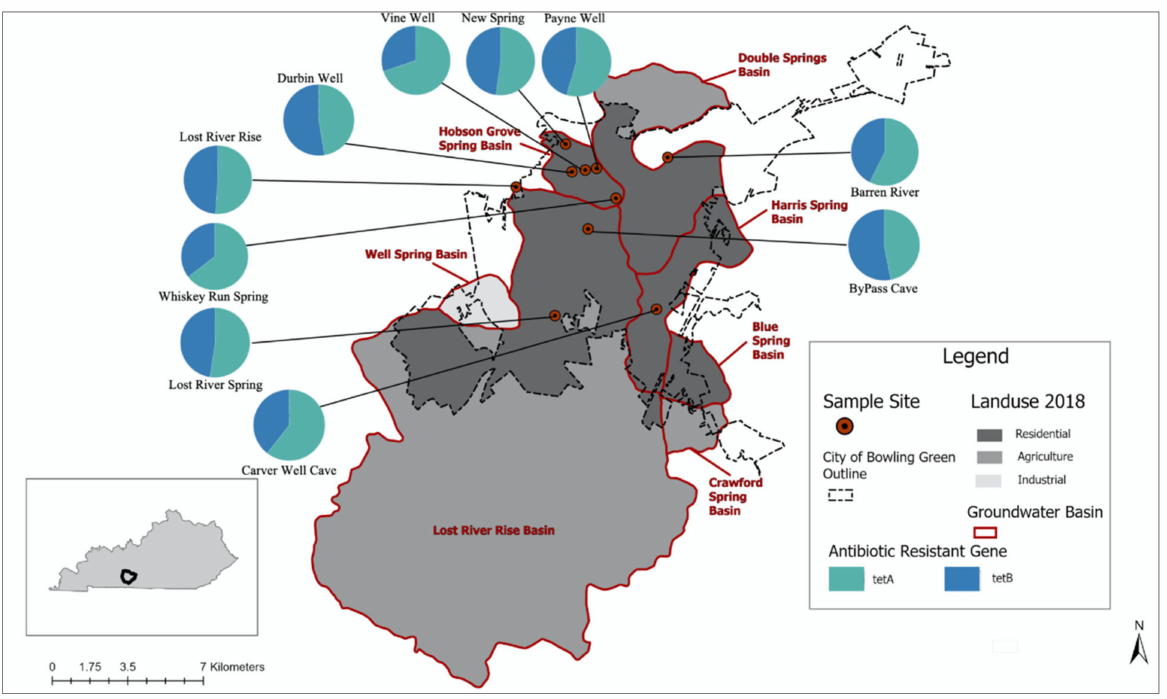
Figure 7. Spatially represented tetracycline ARG detection frequency associated with resistance phenotypes for E. coli and landuse in Bowling Green, KY urban karst